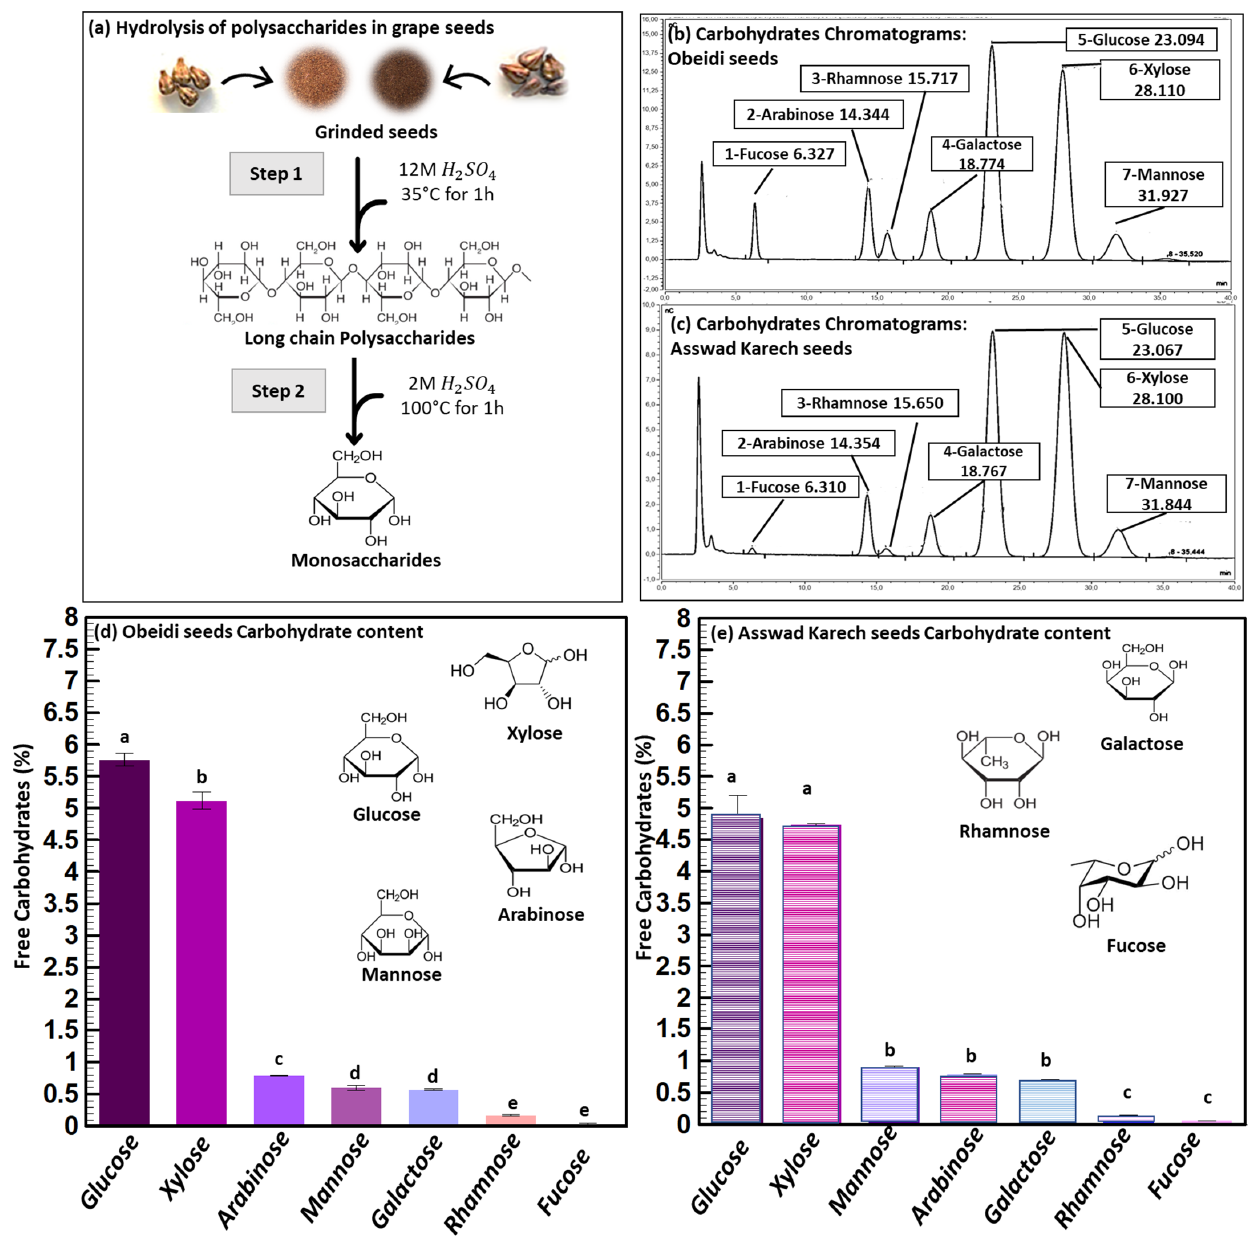
Figure 1. Carbohydrate analysis. ( a ) Schematic overview of the acid hydrolysis of carbohydrates, ( b ) chromatograms of hydrolyzed carbohydrates from Obeidi seeds, ( c ) chromatograms of hydrolyzed carbohydrates from Asswad Karech seeds, and ( d , e ) identification and quantification of carbohydrates in Obeidi and Asswad Karech grape seeds, respectively. Means sharing the same letter are not significantly different from each other (with p > 0.05).